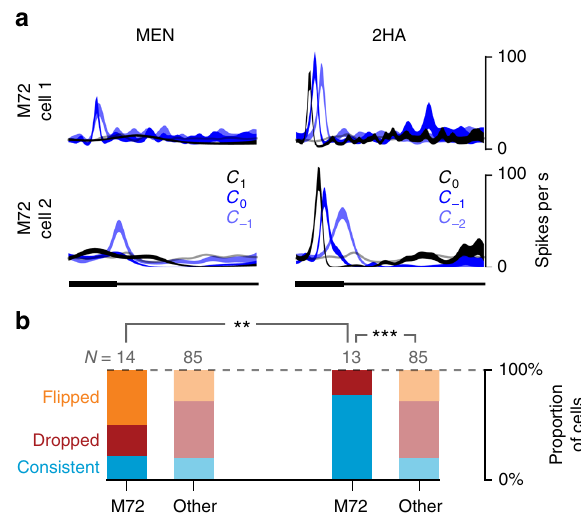
Fig. 6 Individual M72-MT cells ’ responses are consistent across concentrations for 2HA but not for MEN. a Odor responses of two example M72-MT cells to three concentrations of MEN (weak ligand) and 2HA (strong ligand). Shaded areas denote ±1 SEM; light gray trace shows baseline response. b Distributions of cells by category of concentration dependency for MEN (left) and 2HA (right). We de fi ne three categories: "consistent" (cyan) — the response polarity is the same for all three concentrations; "dropped" (red) — there is at least one concentration at which the response did not signi fi cantly differ from baseline; and " fl ipped" (orange) — the response polarity is different at different concentrations. Cells for which the response was not signi fi cantly different from baseline in all three concentrations were omitted. Pairwise comparisons: